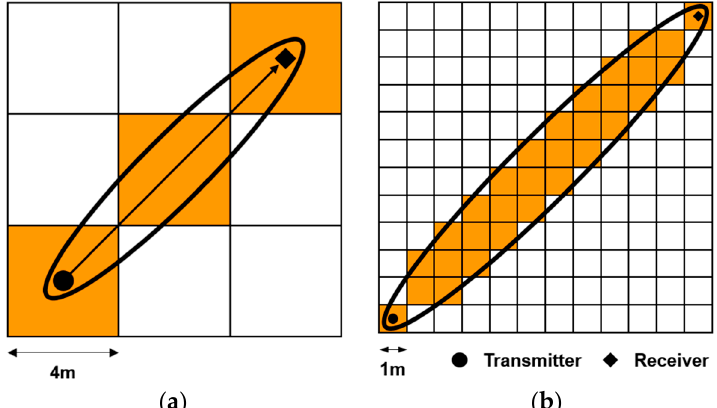
Figure 2. Comparison of the cells included in the 1st Fresnel zone when using a ( a ) low-resolution DSM and ( b ) high-resolution DSM.